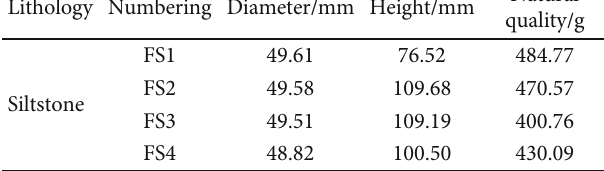
Table 2: Basic parameters of pressure-absorbing siltstone